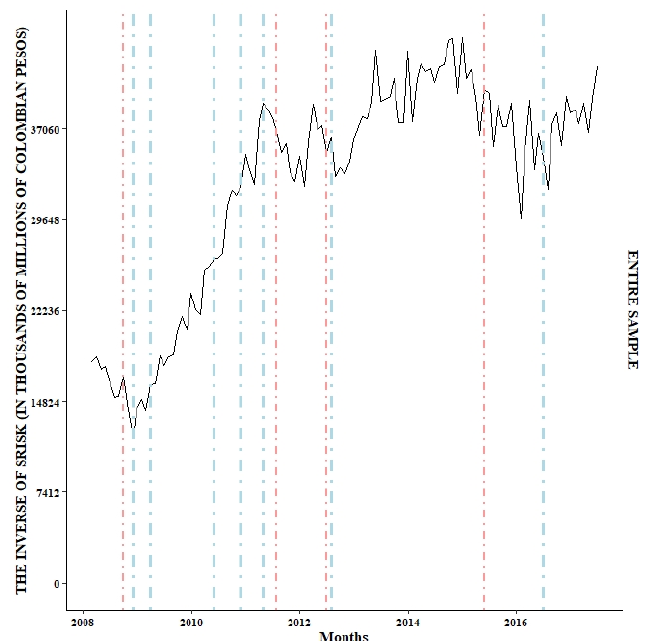
Figure 4. Monthly behavior of the SRISK systemic risk measure for the entire sample. Source: owner.